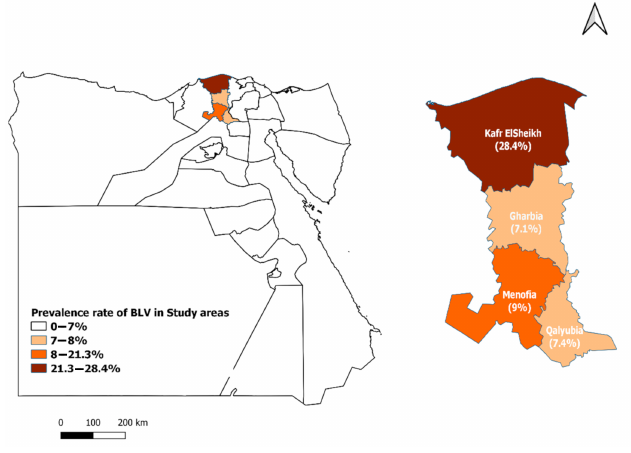
Figure 1. Seroprevalence rate and location of different Governorates in the